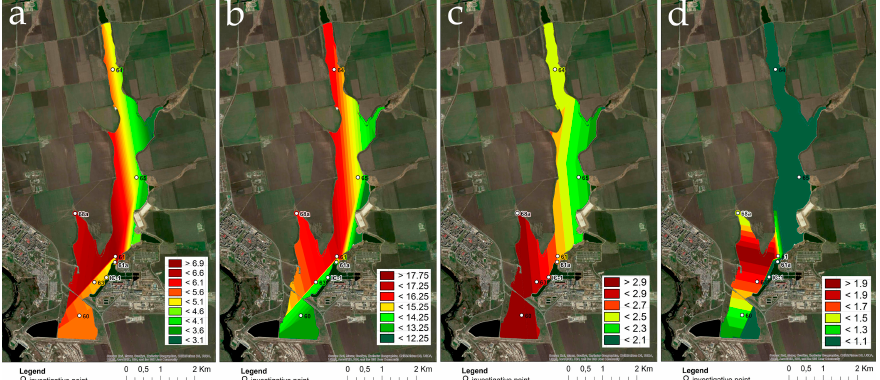
Figure 11. Combined statistical and landscape maps for the Alexandrovskoye reservoir. Abundance ( a ); Index saprobity S ( b ); Ammonia ( c ); Index WESI ( d ). Colors are given for the value amplitude of each mapped variable from green (lower boxes in the legend key) to red (upper boxes in the legend key).